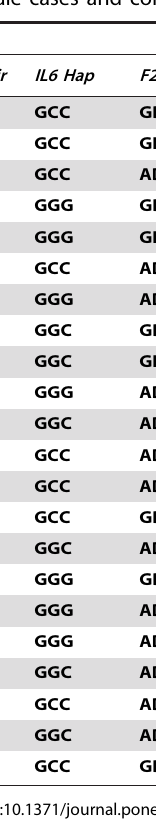
Table 1. Absolute frequency of IL6*F2R haplotype pairs in male cases and controls.